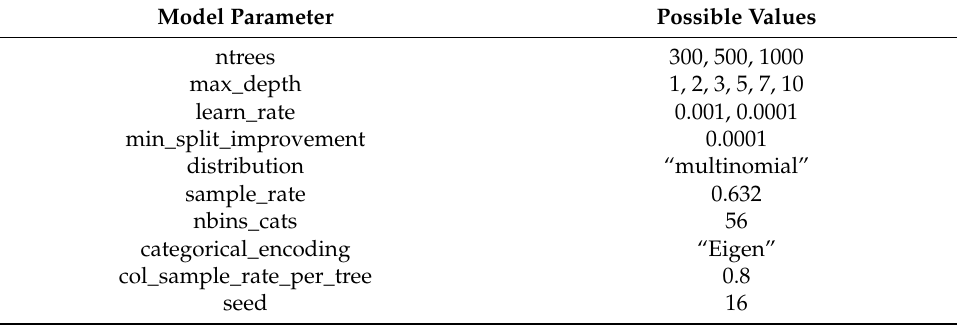
Table 8. Tuning Parameters for Gradient Boosted Forest Frequency